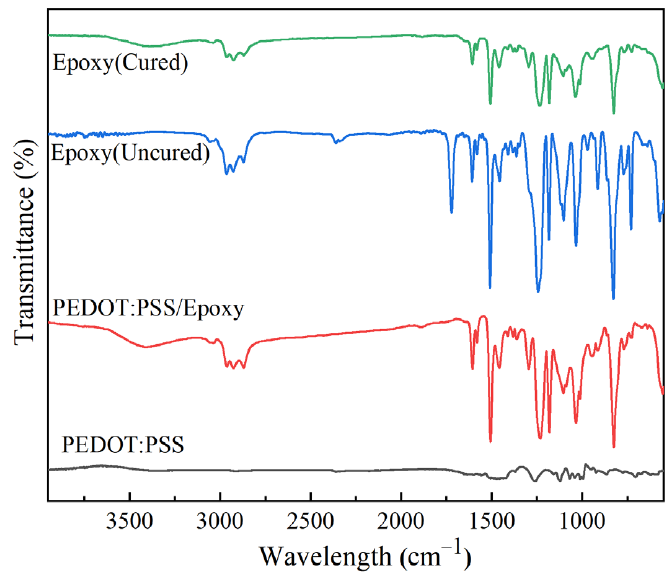
Figure 9. Infrared spectra of epoxy (cured), epoxy (uncured), pristine PEDOT:PSS, and PE- DOT:PSS/epoxy coatings.